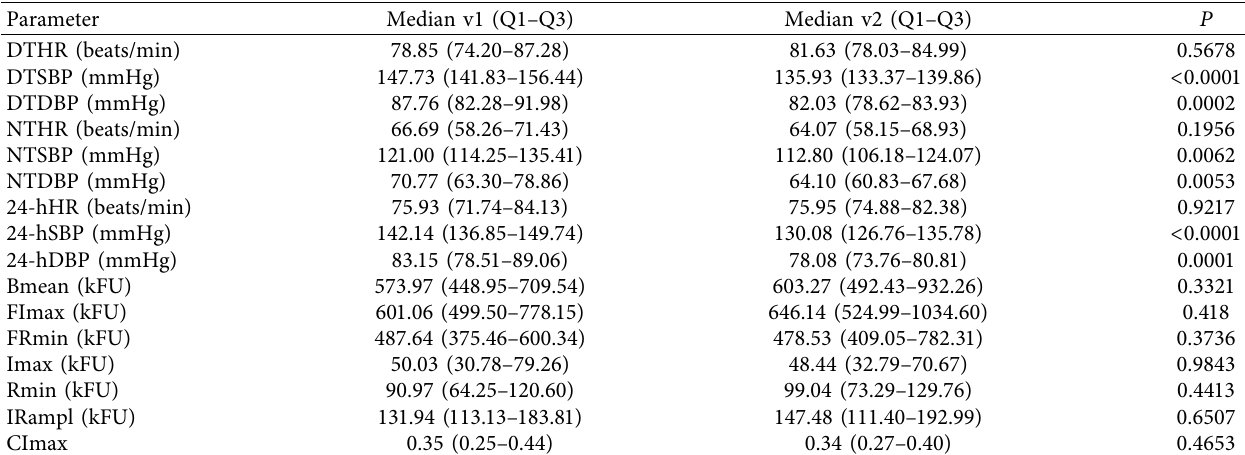
Table 3: Summary of continuous measures for hypertensive patients assigned to perindopril at 5mg QD. P values of the paired analysis of continuous data with a nonparametric Wilcoxon test for comparison of results before and after the six-week treatment.